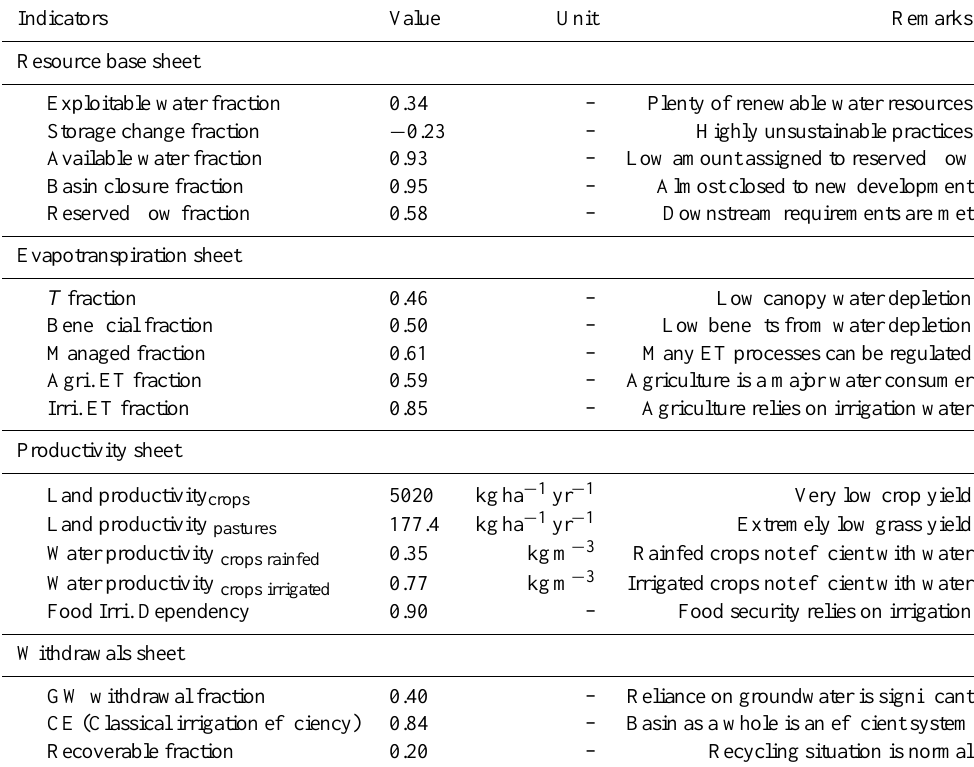
Table 3. WA + indicators for the Indus basin based on the situation in